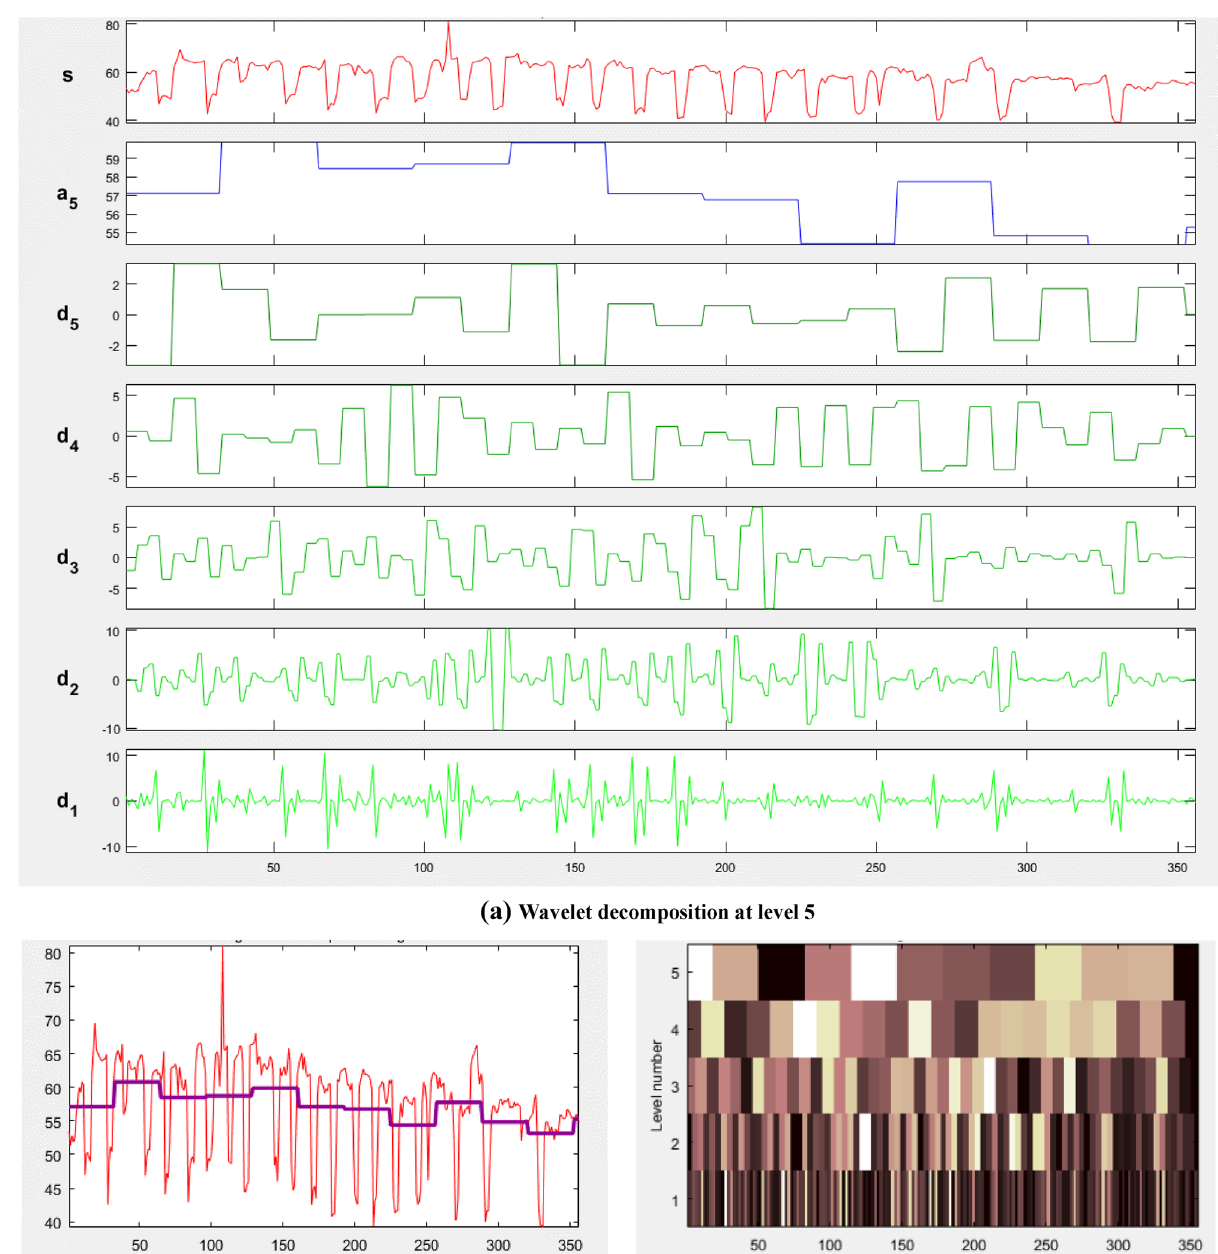
Fig. 5 Wavelet analysis results with PCA component 1 of mud logger dataset in well B, a wavelet decomposition at level 5, b the comparison of original signal and compressed signal, c the original coefficients at each